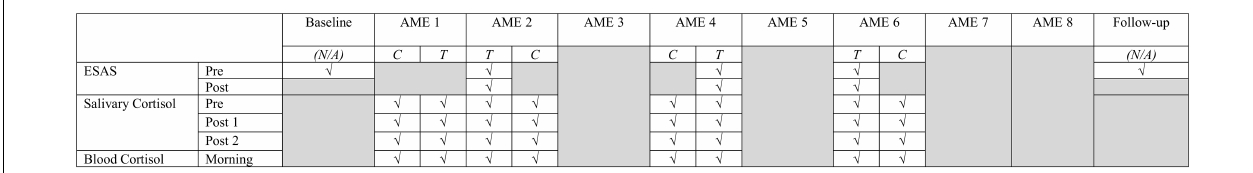
FIGURE 4 | Simplified collection schedule for self- and proxy-report measures (ESAS), salivary cortisol, and blood cortisol. As shown in Figures 2 , 3 , the correspondence of AME sessions and data collection varied for children undergoing autologous and allogenic transplants; for illustrative purposes, this figure depicts days for a child undergoing an autologous transplant. Pre, Post, and Morning refer to the time of day during which samples were collected. Pre indicates that data collection occurred before the AME session, whereas Post indicates collection occurred after the session (Post 1 and Post 2) are used to indicate that data were collected twice after the session. C and T refer to control and treatment condition days within each pair of days on which data were collected for a given AME